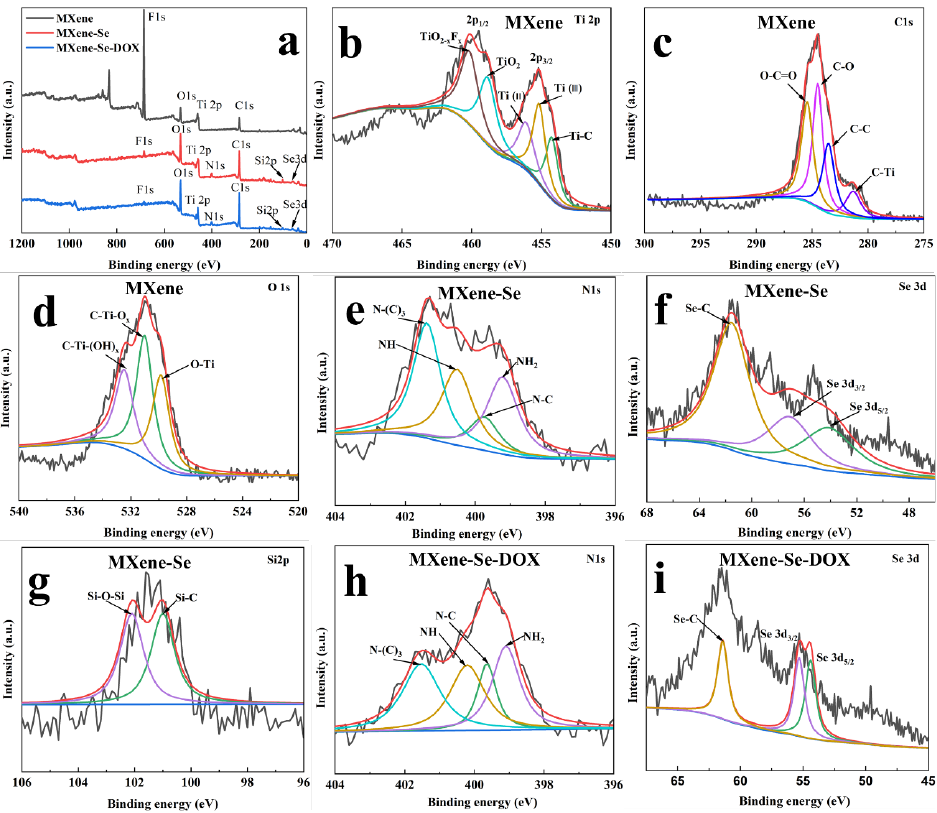
Figure 5. XPS spectra of MXene, MXene-Se, and MXene-Se-DOX nanosheets. ( a ) Survey scan spectrum of MXene, MXene-Se, and MXene-Se-DOX. ( b – d ) Ti 2p, C 1s, and O 1s spectra for MXene. ( e – g ) N 1s, Se 3d, and Si 2p spectra for MXene-Se. ( h , i ) N 1s and Se 3d spectra for MXene-Se-DOX. Table 1. Atomic concentrations of elements on the surfaces of MXene, MXene-Se, and MXene-Se- DOX nanosheets.